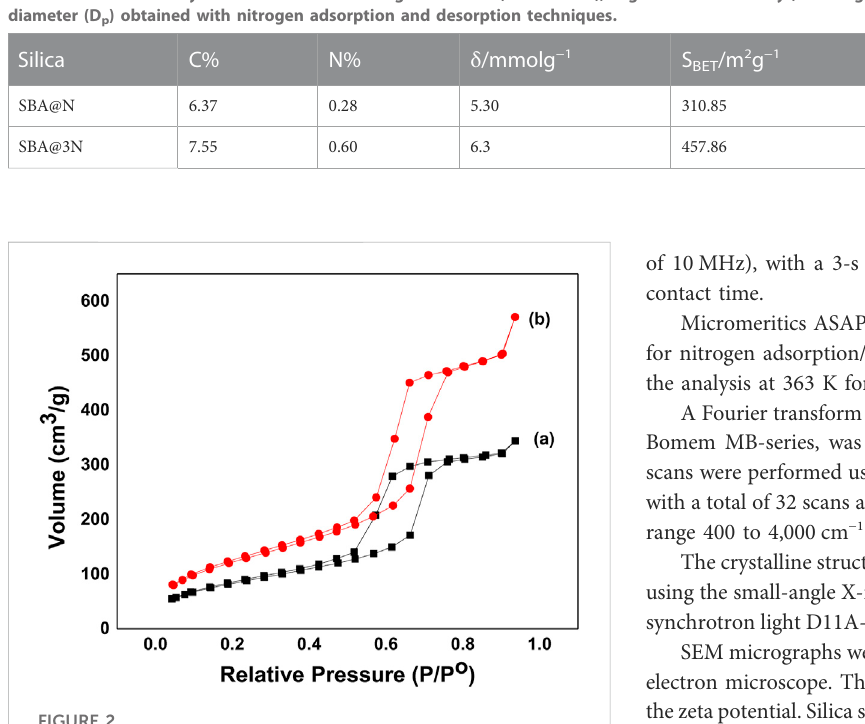
FIGURE 2 Nitrogen adsorption/desorption graphs for (a) SBA@N and (b)